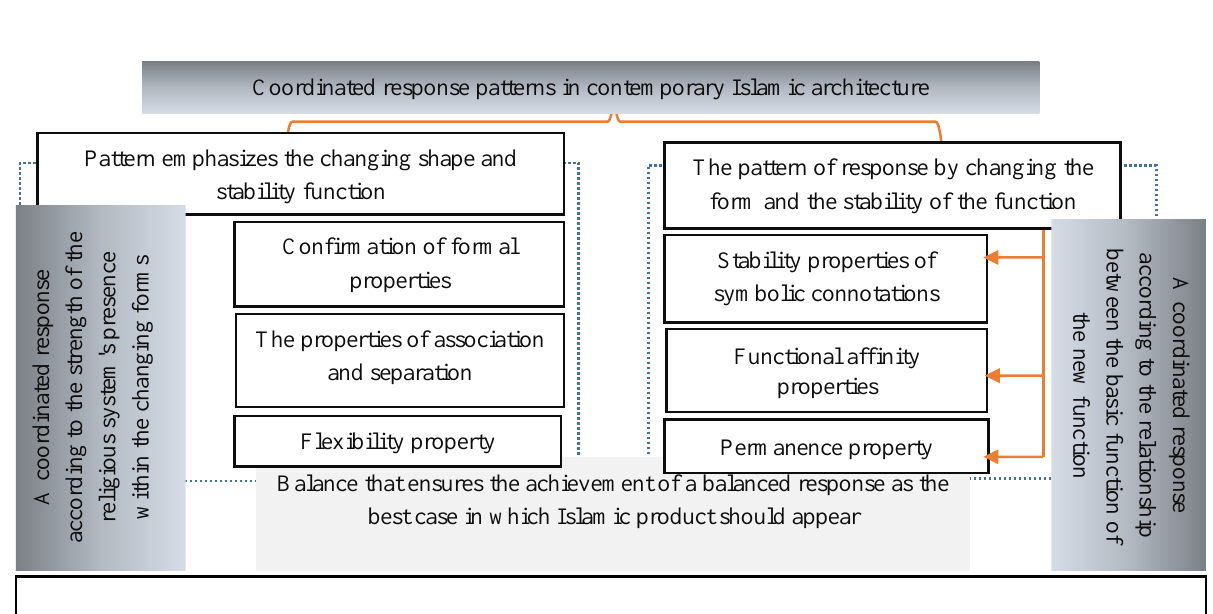
Fig. 1. shows the structure adopted in diagnosing the coordinated response in the product of Islamic architecture. Source: the